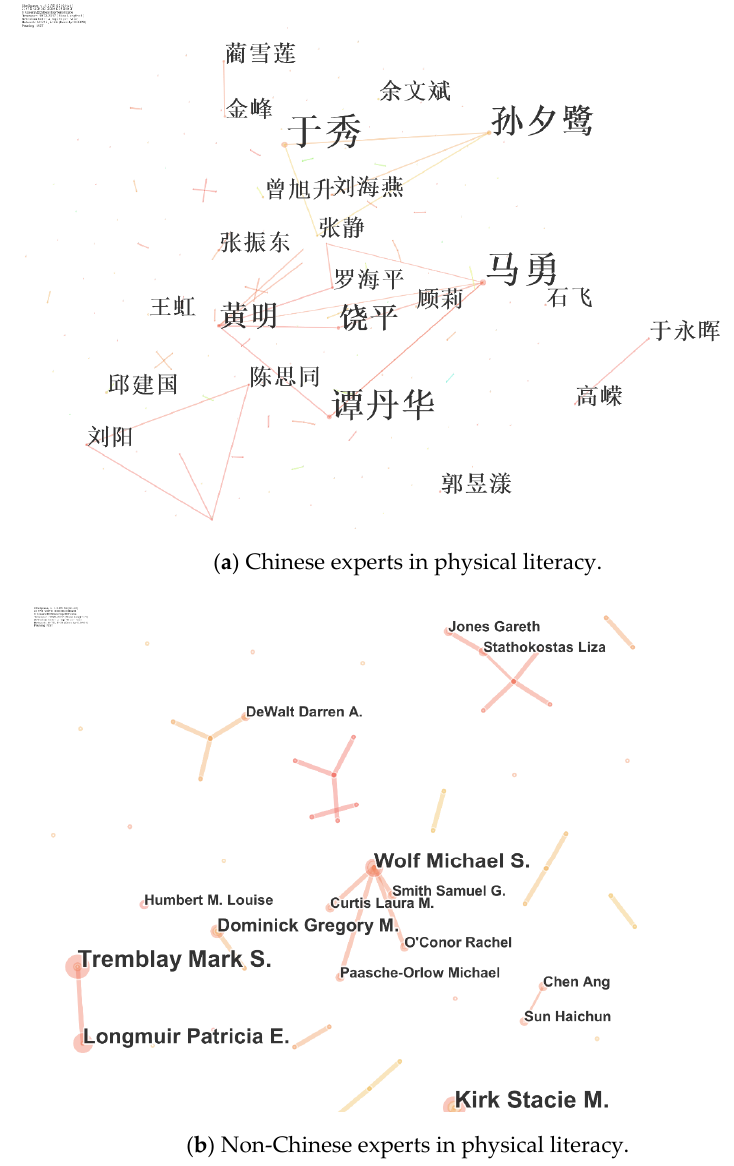
Figure 1. The selected experts participating in the Delphi process by CiteSpace.